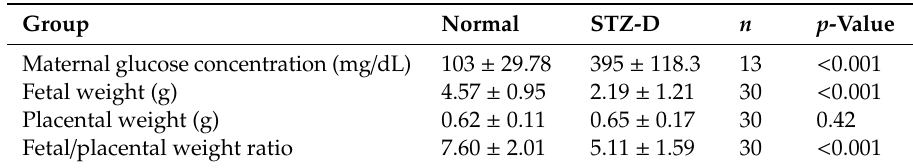
Figure 1. Pregestational diabetes led to fetal growth restriction and decreased placental efficiency in streptozotocin-induced diabetes (STZ-D) rats. ( A ) Maternal plasma glucose levels of normal and STZ-D rats ( n = 13). ( B ) Representative pictures of abnormal growth of the fetus and placentas in STZ-D rats: a, normal placenta; b, STZ-D placenta; c, normal fetus; d, STZ-D fetus. ( C ) Birthweight from normal and STZ-D rats, showing that STZ-D pregnant rats had decreased birthweight compared with normal rats ( n = 30). ( D ) Placental weight derived from normal and STZ-D rats ( n = 30). ( E ) Fetal weight / placental weight ratio ( n = 30) showing that STZ-D rats had decreased fetal to placental weight ratio. Data are expressed as mean ± SD. *** p < 0.001, normal versus STZ-D. Table 1. Data of maternal glucose concentration, fetal and placental weight, and fetal/placental weight ratio in normal and STZ-D rats.